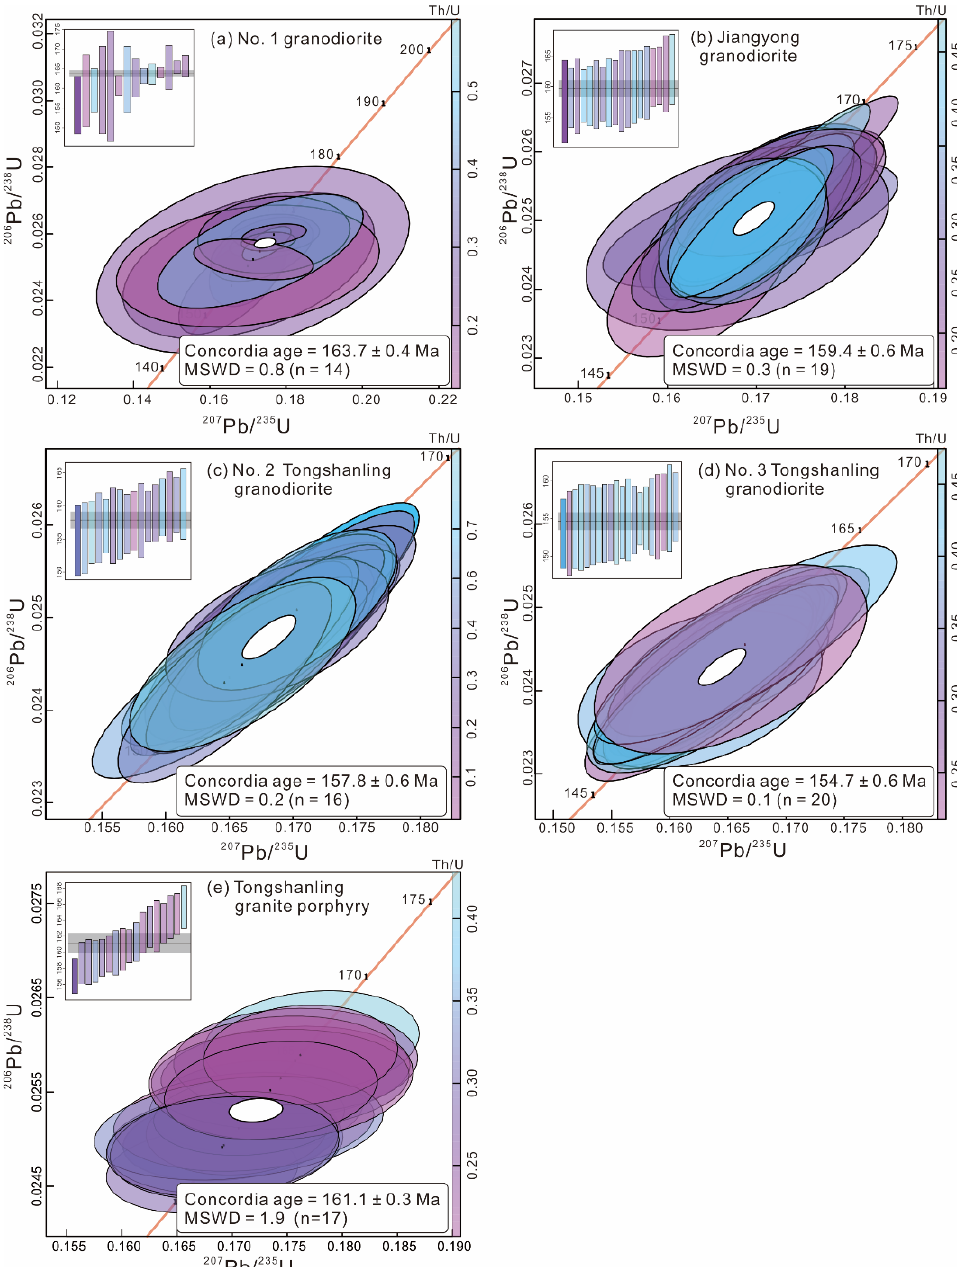
Figure 7. Concordia diagrams for UPb dating of zircons from ( a ) No. 1 granodiorite; ( b ) Jiangyong granodiorite; ( c ) No. 2 granodiorite; ( d ) No. 3 granodiorite; and ( e ) No. 1 granodiorite. Different colors of error ellipses reflect the Th/U ratios of zircons as shown on the right side of each diagram.